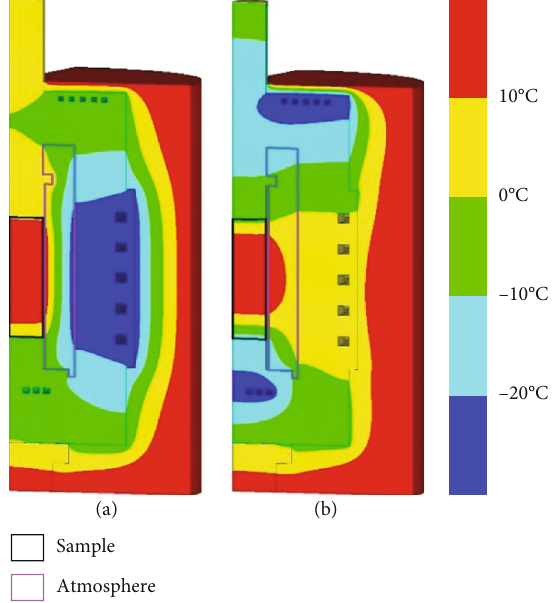
Figure 10: Simulated temperature fi elds in the fi nite element model under cooling by (a) the lateral freezing channel and (b) the upper and lower freezing channels with a constant temperature constraint of -25 ° C for 40min.